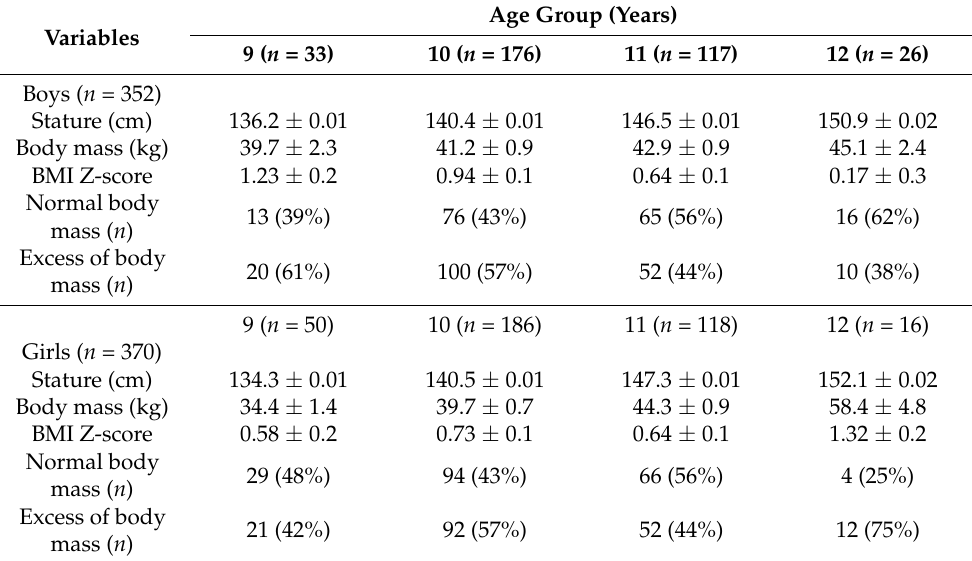
Table 1. Anthropometric characteristics in children from the Mexico–USA border.